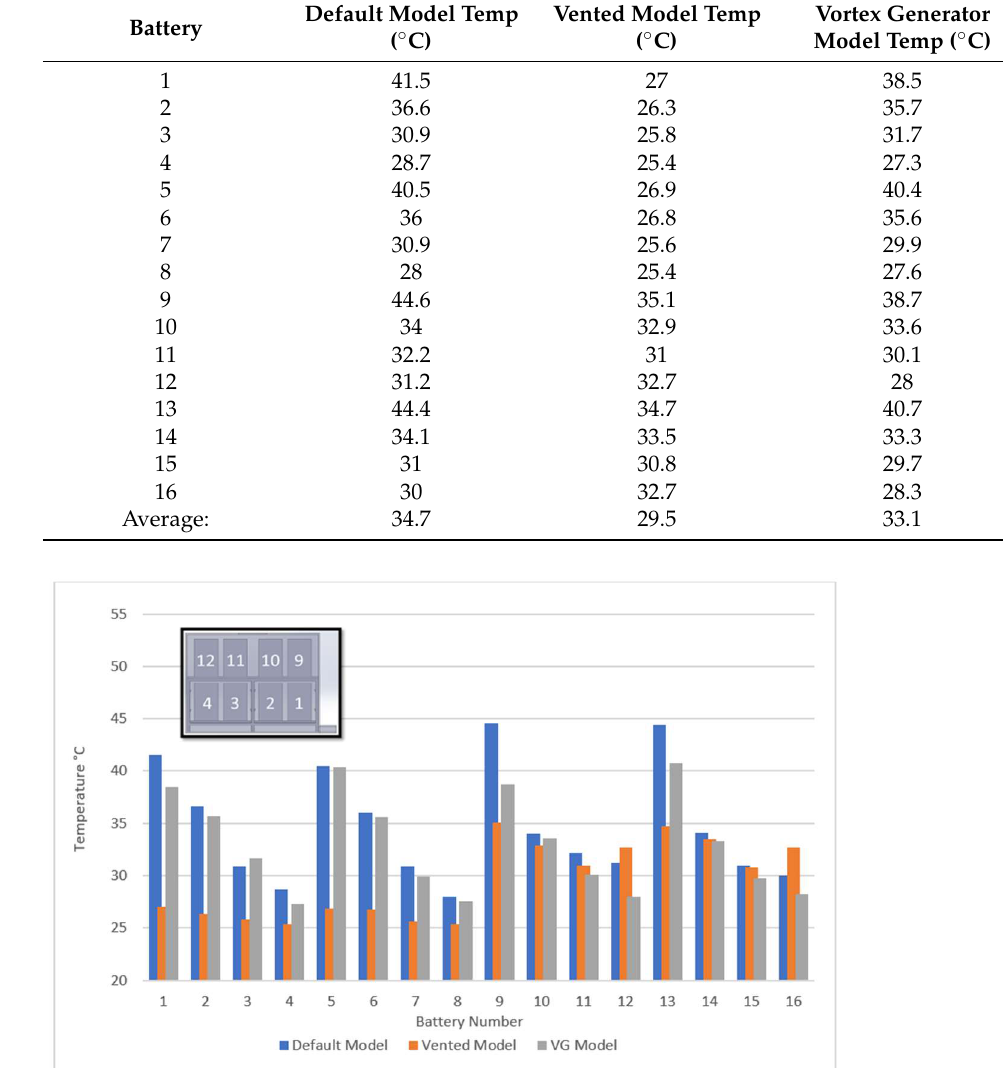
Table 6. Battery simulation temperatures for the full-scale default, vented, and vortex generator cooling design models.